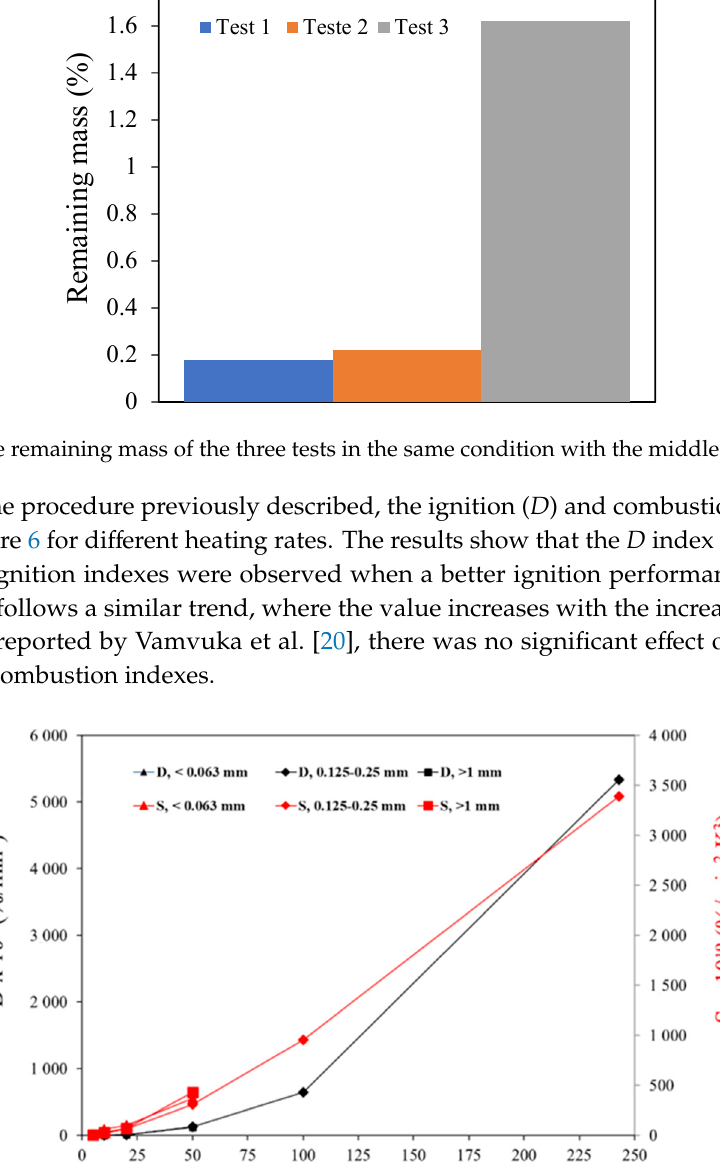
Figure 6. Combustion indexes of the pine wood particles at di ff erent heating